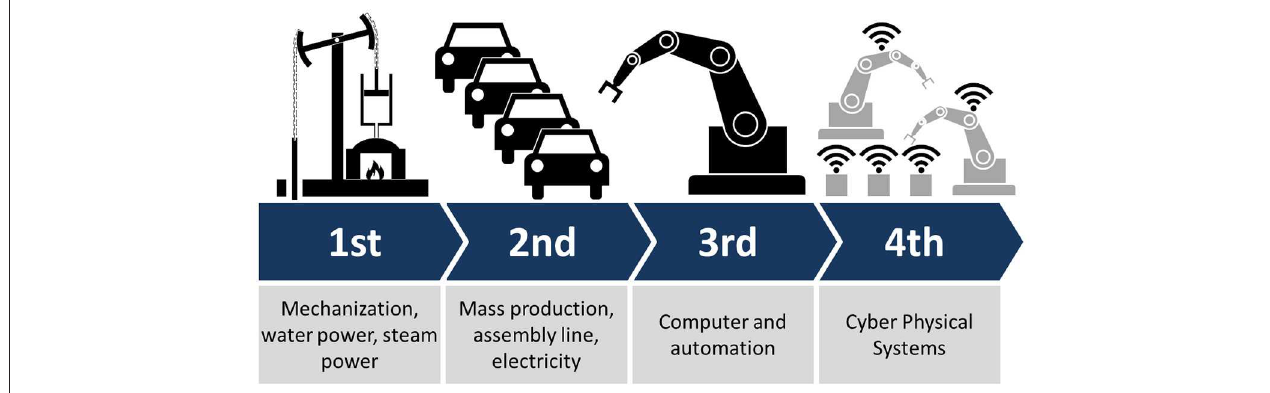
FIGURE 1 | The four industrial revolutions. From the Wikimedia Commons. Christoph Roser at AllAboutLean.com licensed under the Creative Commons Attribution-Share Alike 4.0 International license (Roser,